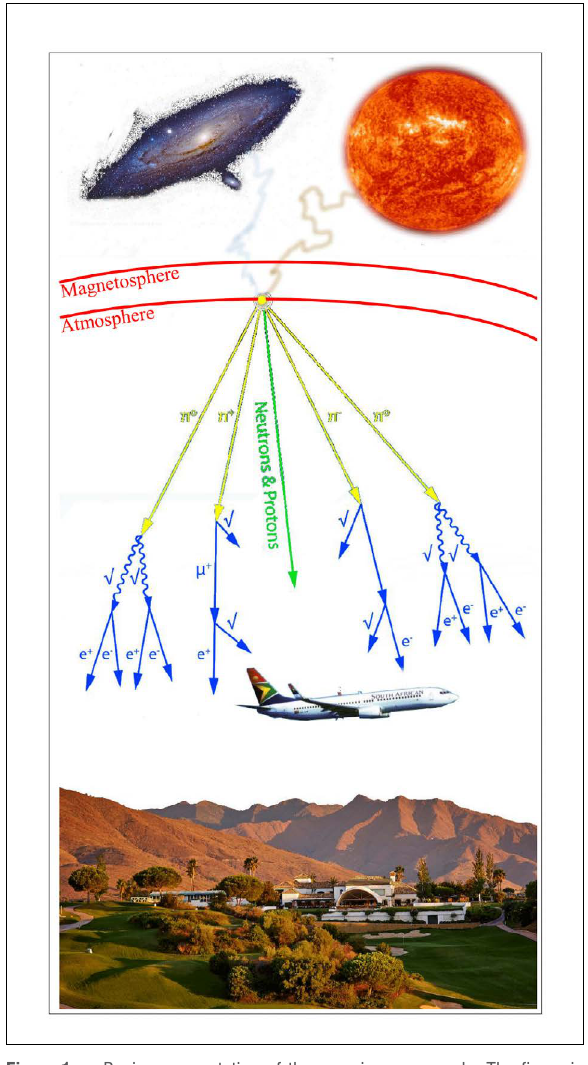
Basic representation of the cosmic ray cascade. The figure is not to